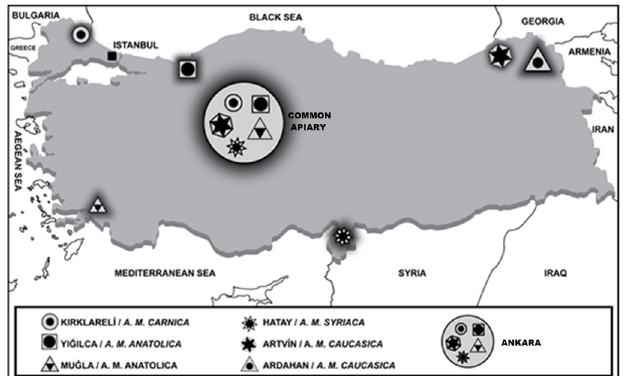
Fig 1. The distribution of native honeybee subspecies of Turkey and sampled provinces indicated by different symbol Extraction